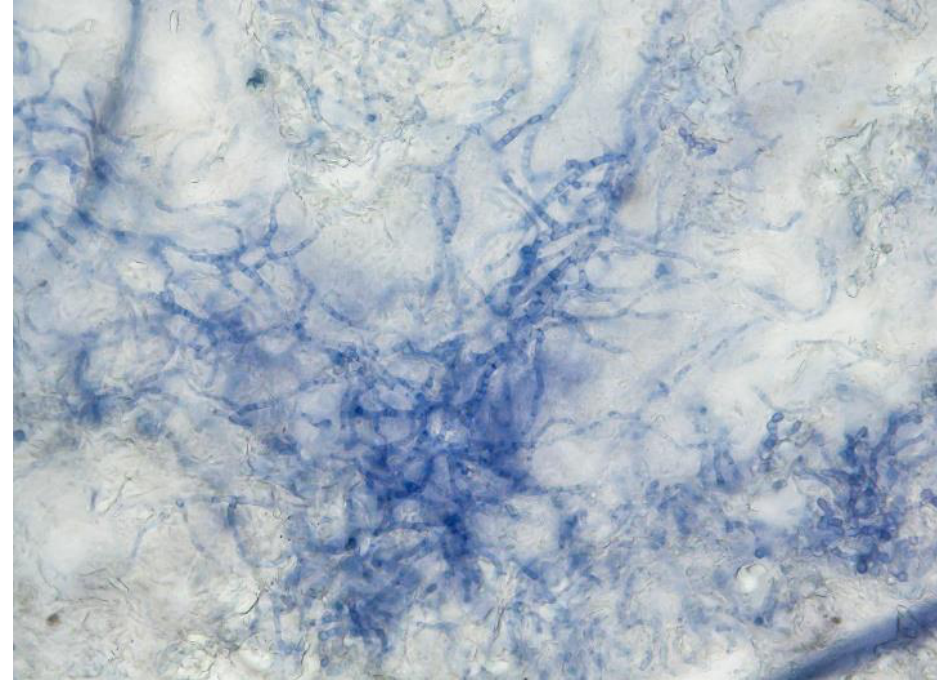
Figure 1. Direct microscopic examination of Trichophyton quinckeanum in a skin lesion sample (KOH + Myco-Ink stain, 400× magnification).